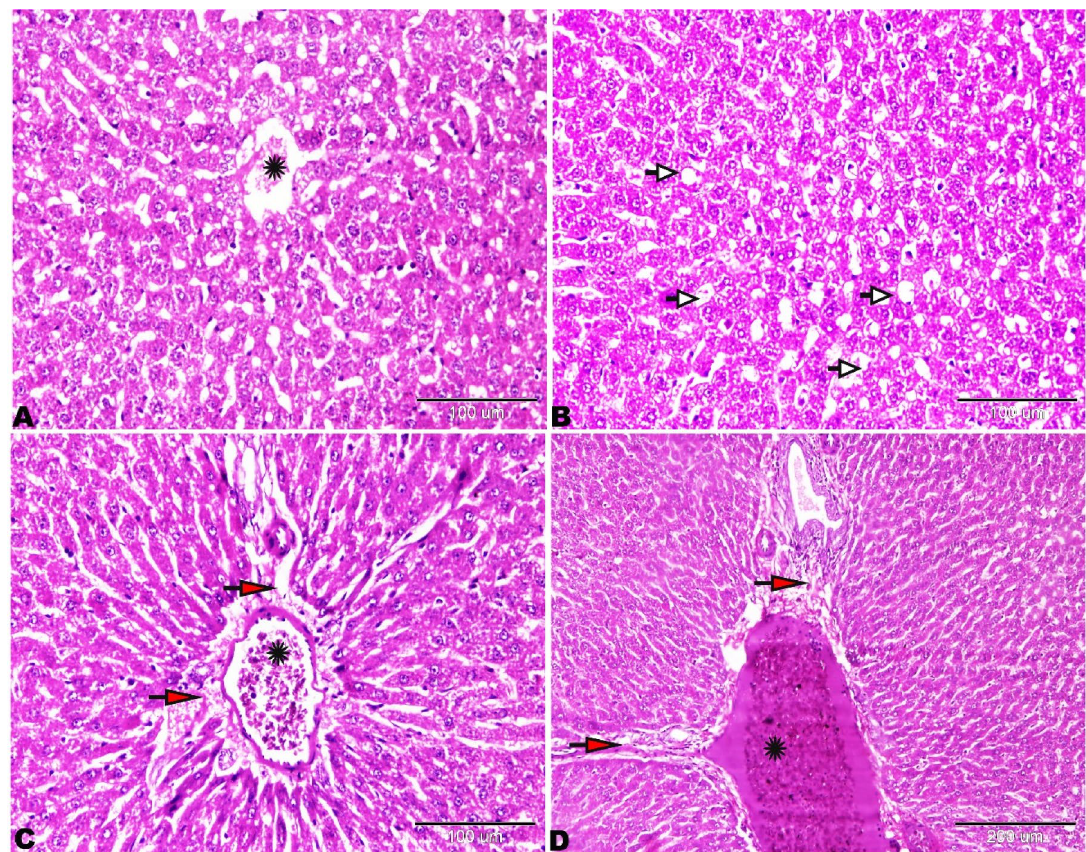
Figure 10. Photomicrograph of the rat livers of Group III (treated with basal diet 70% + cheese containing L. helveticus 30%). ( A ) Degeneration of the endothelium lining the central vein (star). ( B ) Vacuolar degeneration of hepatocytes (white arrows). ( C , D ) Portal area showing congestion in the portal veins with mononuclear inflammatory cellular infiltration (star), periportal fibroses (red arrows). H&E stain, the bar size was indicated under